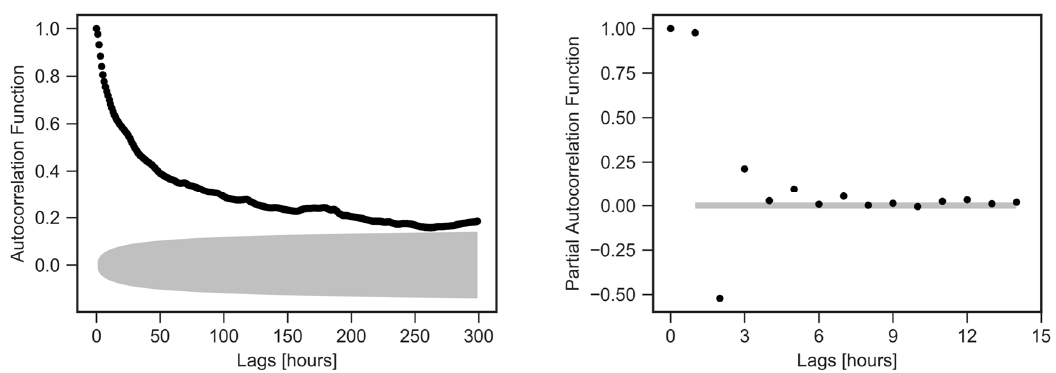
Figure 3. Autocorrelation function (ACF) and Partial autocorrelation function (PACF) of the Matadero-Sayausí discharge series. Gray hatch indicates the 95% confidence band.